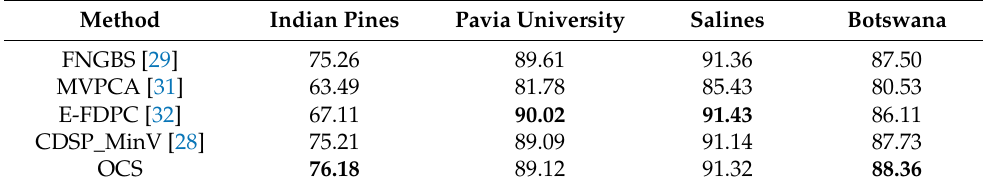
Table 7. AOA of SVM on four public datasets